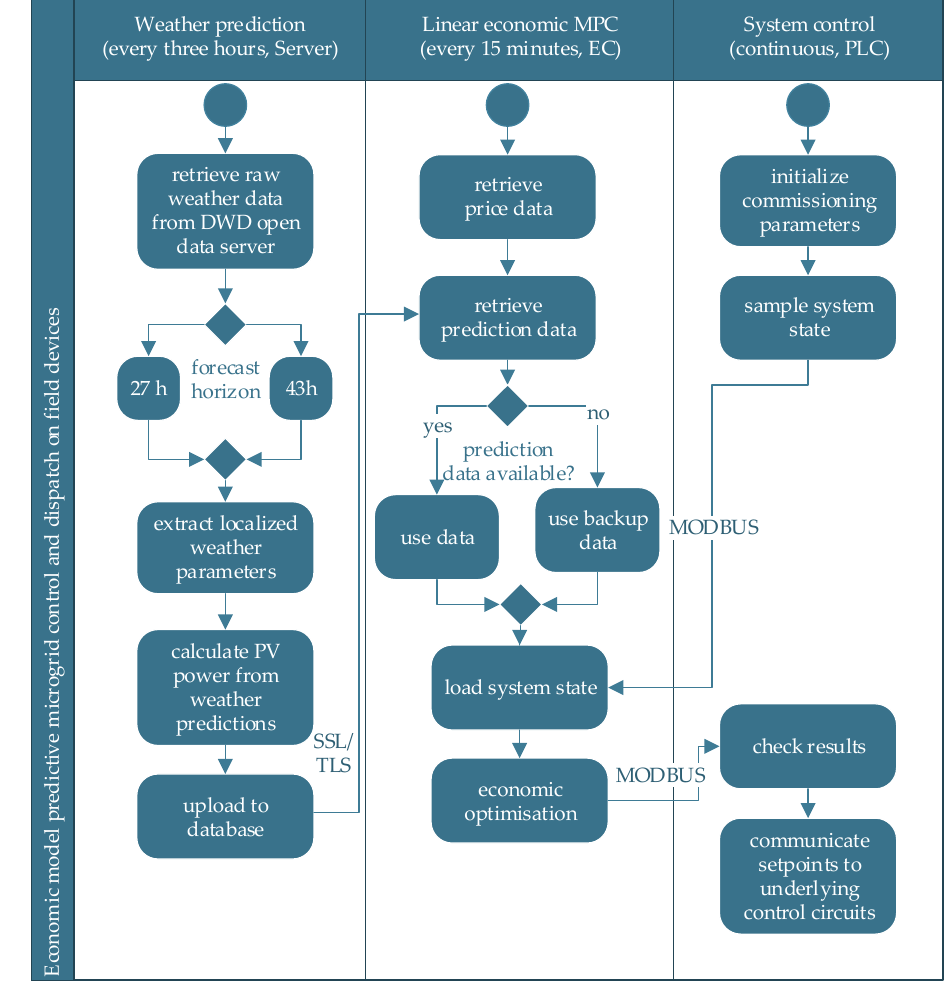
Figure 3. UML activity diagram of the economic MPC implementation on server, EC and